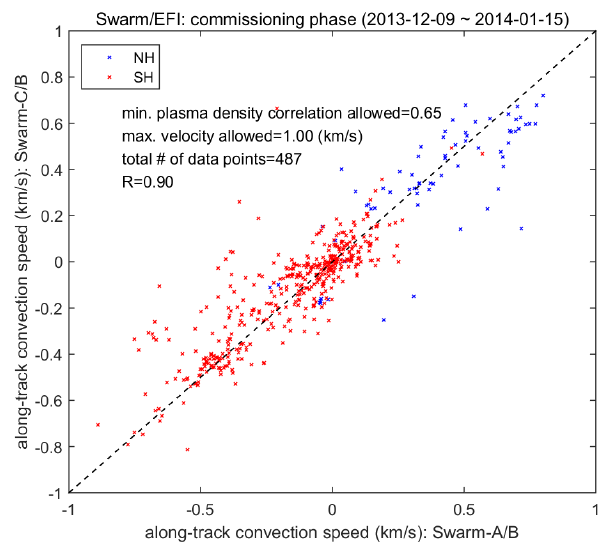
Figure 3. Correlation diagram between the along-track plasma drift speed obtained by the Swarm-B–A pair and the Swarm-B–C pair. Each data point corresponds to one 1min data segment, as shown in Fig. 2. Blue and red crosses represent observations in the Northern and Southern Hemisphere, respectively. The dashed line represents perfect correspondence between the abscissa and the